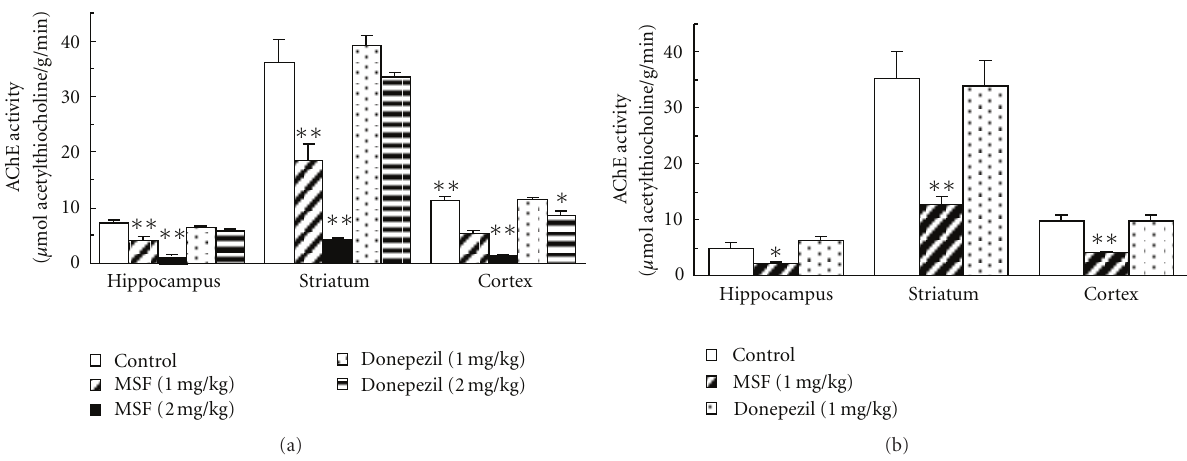
Figure 3: E ff ect of MSF and donepezil on the activity of AChE in brain regions 180 min (a) and 24 hr (b) after administration. Each value represents the mean ± S.E.M. of five experiments. Asterisks indicate e ff ects significantly di ff erent from time course vehicle control ( ∗ P < 0 . 05, ∗∗ P < 0 .